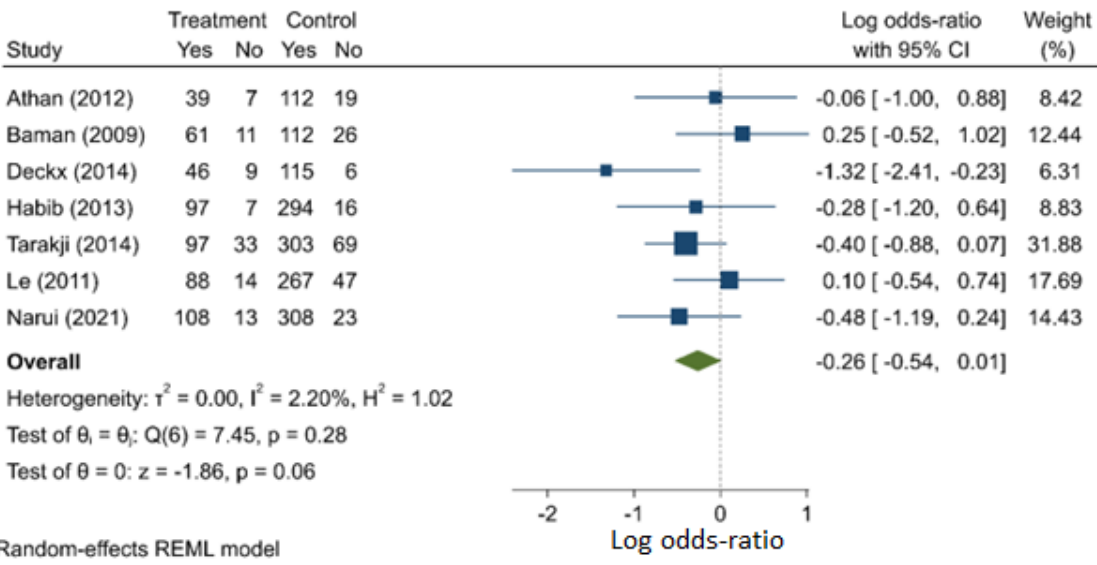
Figure 5. Males compared with females as a risk factor for mortality.